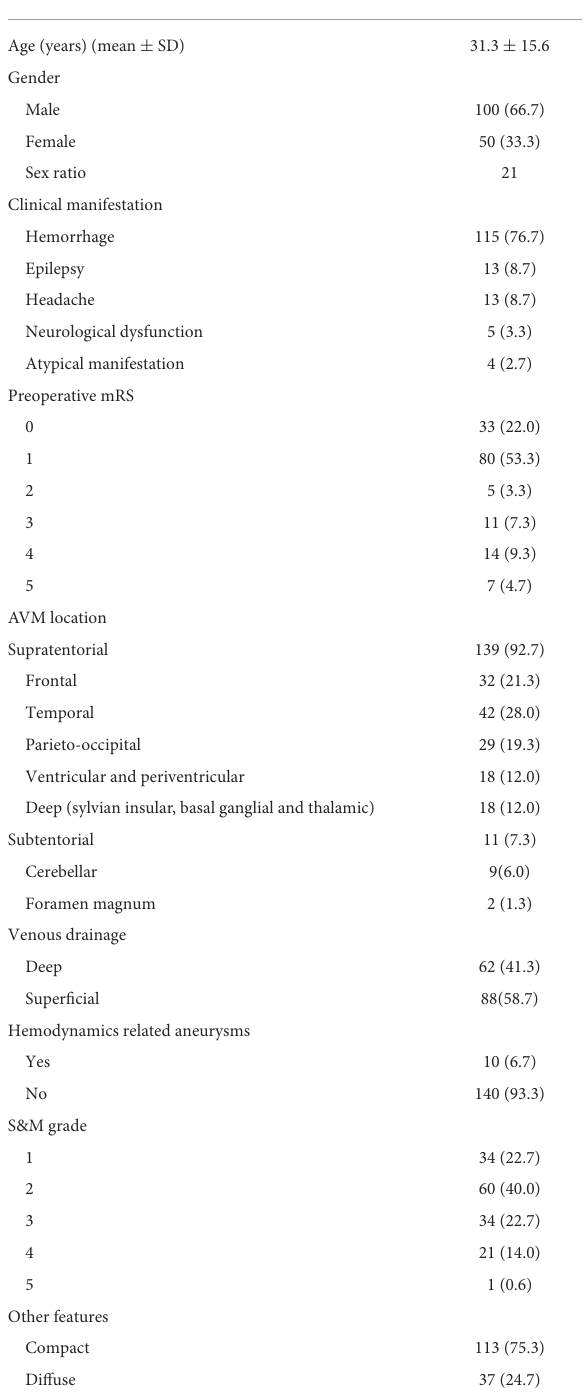
TABLE 1 Patient’s